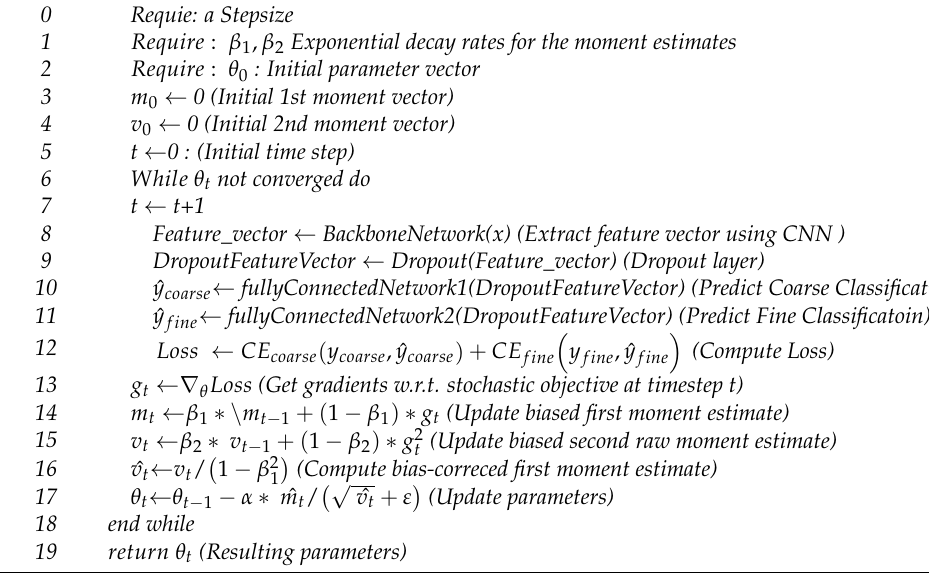
Table A1. The pseudocode of the model